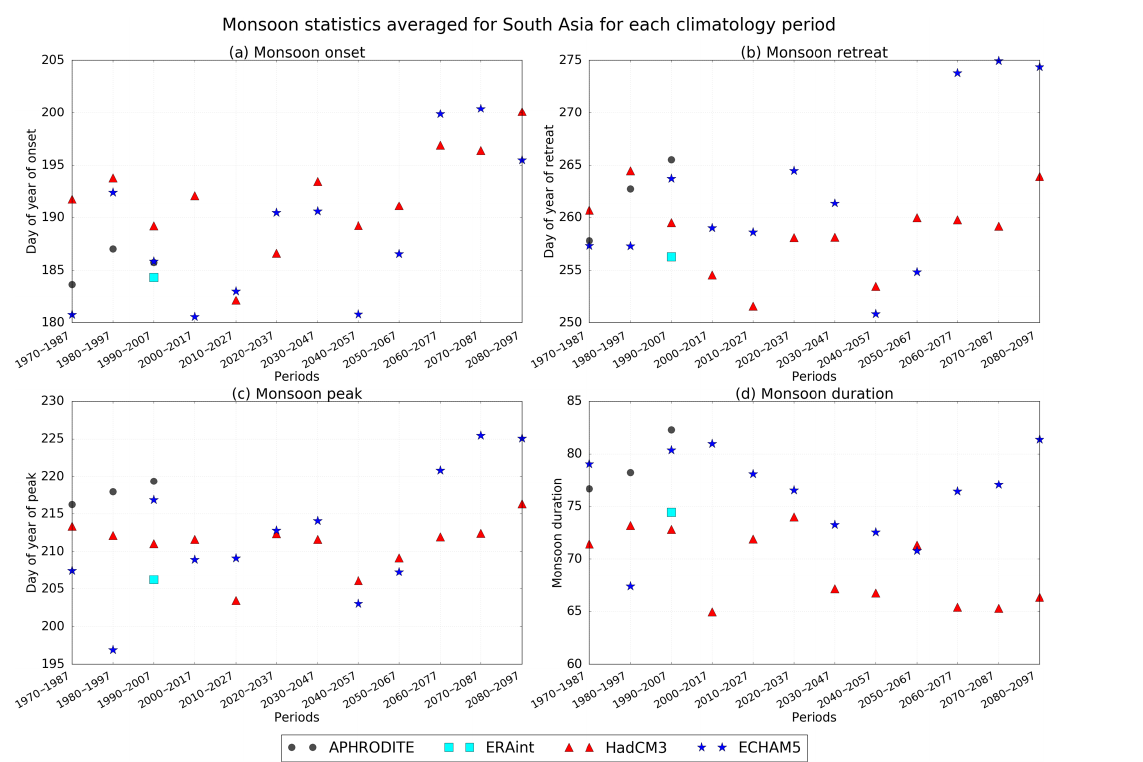
Figure 10. Monsoon statistics: onset (a) , retreat (b) , peak (c) , and duration (d) averaged for South Asia for 12 total 17-year time slices between 1970 and 2097 to provide a time series of values for the region to assess the variability of the